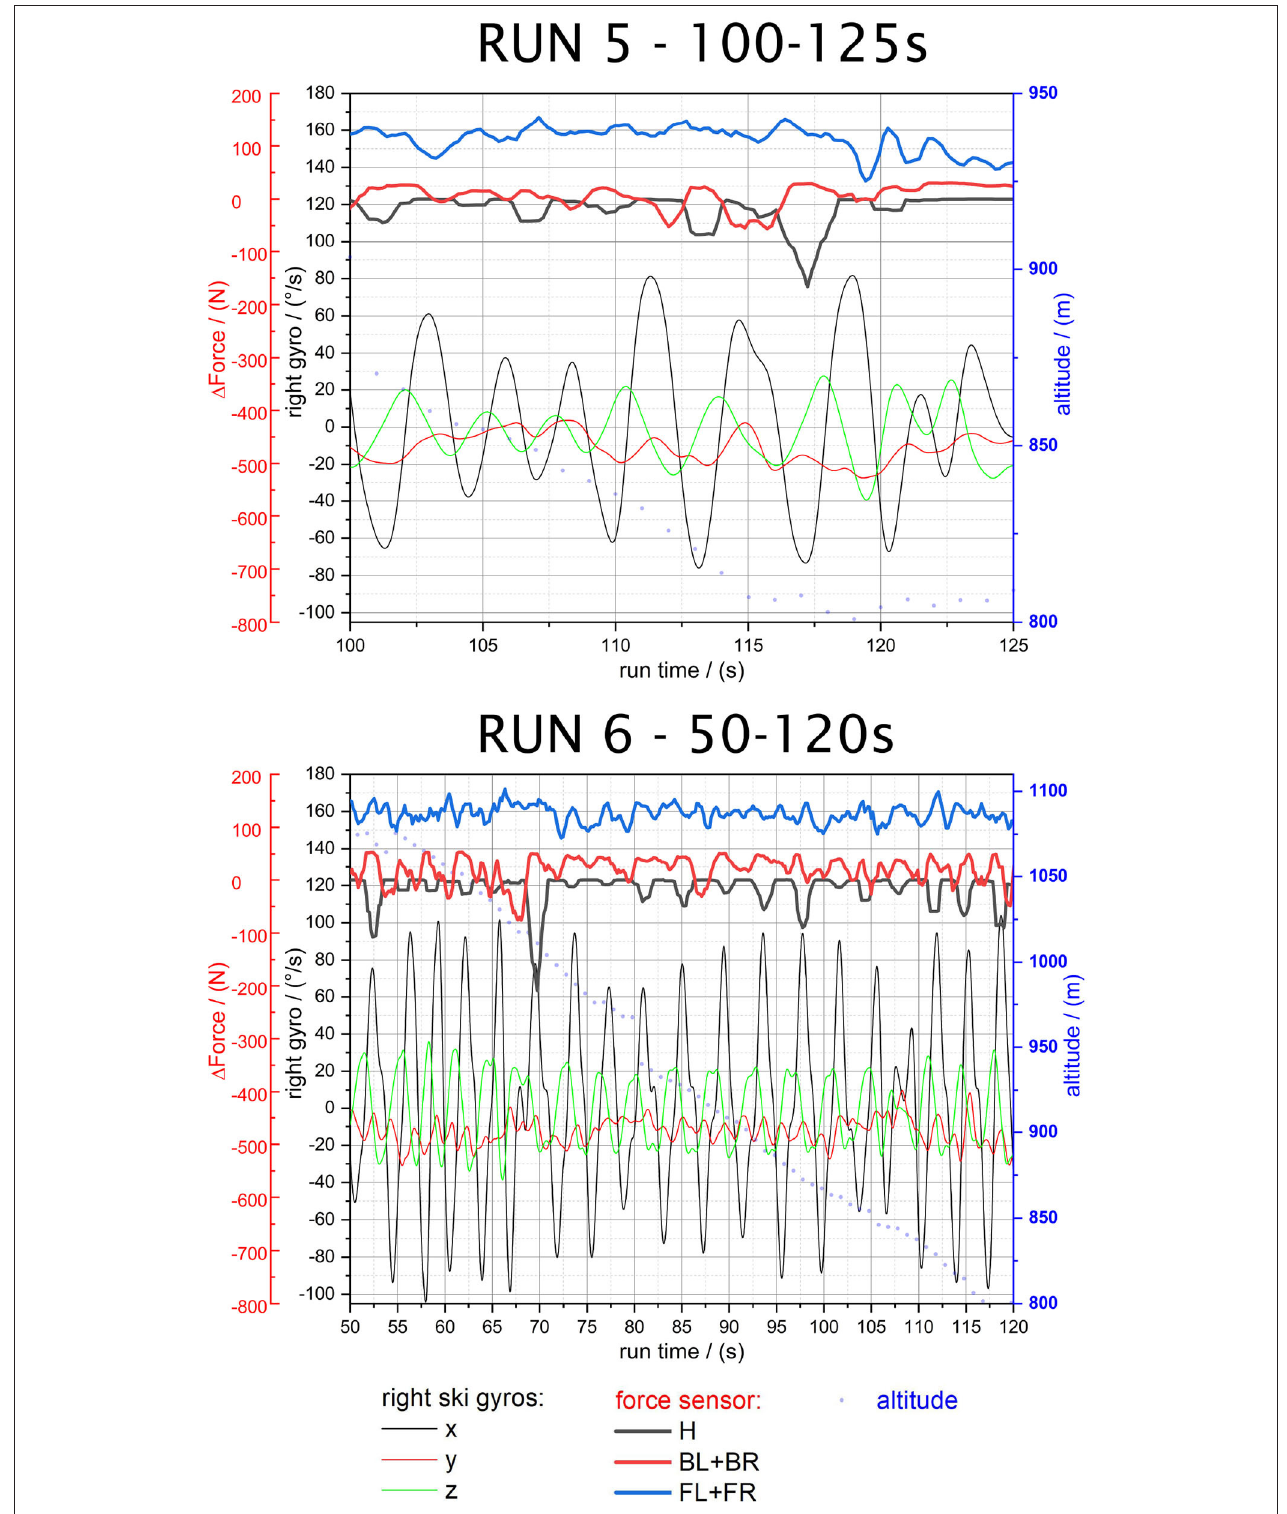
FIGURE 8 | Run 5—125–150 s and Run 6—50–120